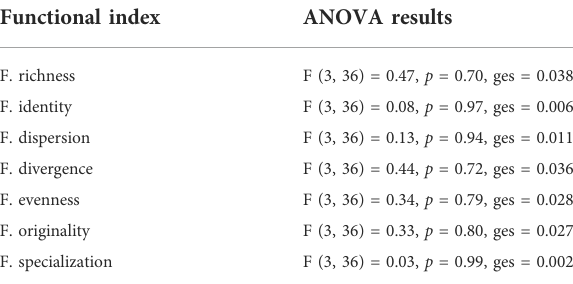
TABLE 4 Summary of the ANOVA results for the calculated functional indices. None of the indices changed signi fi cantly (with α = 0.05) across the sampling sites. See also Figure 4 and refer to text to have additional references on each